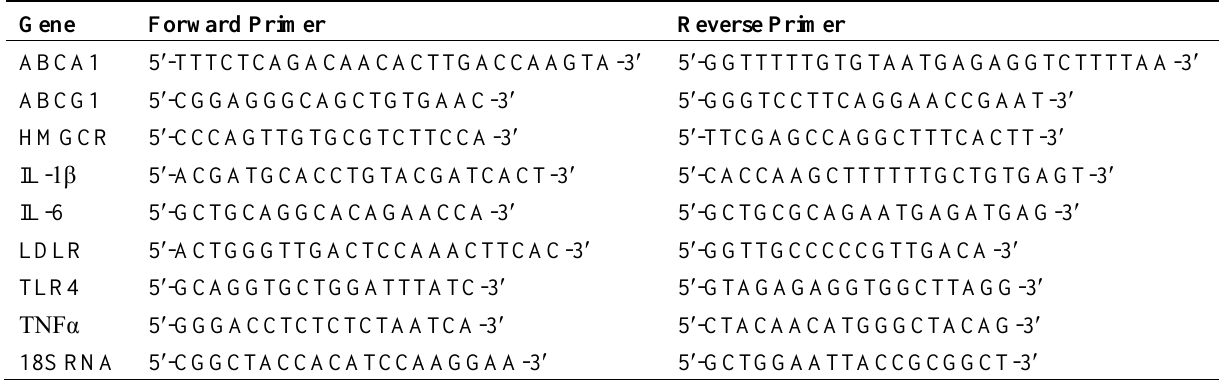
Table 1. Quantitative real-time RT-PCR primer